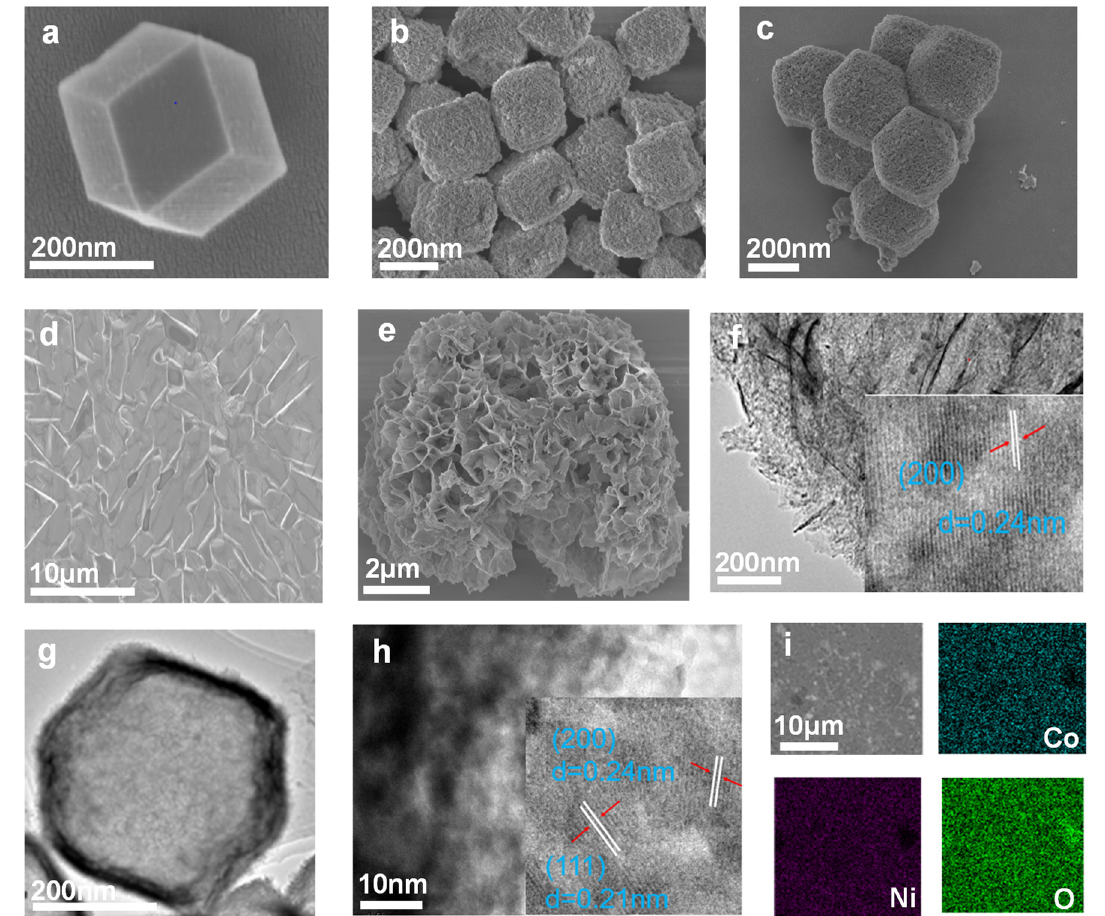
Figure 1. The SEM and TEM images. The SEM image of ( a ) ZIF-67, ( b ) NiCo-LDH(B), ( c ) CoNiO 2 (B), ( d ) NiCo-LDH(F), and ( e ) CoNiO 2 (F). TEM images of ( f ) CoNiO 2 (F) and ( g ) CoNiO 2 (B). ( h ) HRTEM images of CoNiO 2 (B). ( i ) EDS elemental mapping of CoNiO 2 (B).